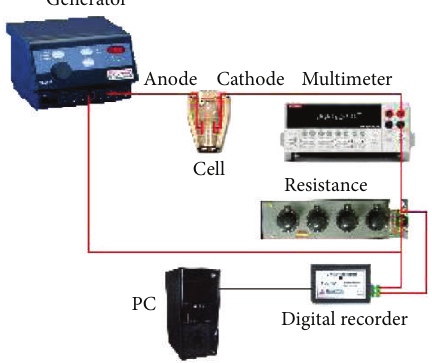
Figure 1: Scheme of anodization system.